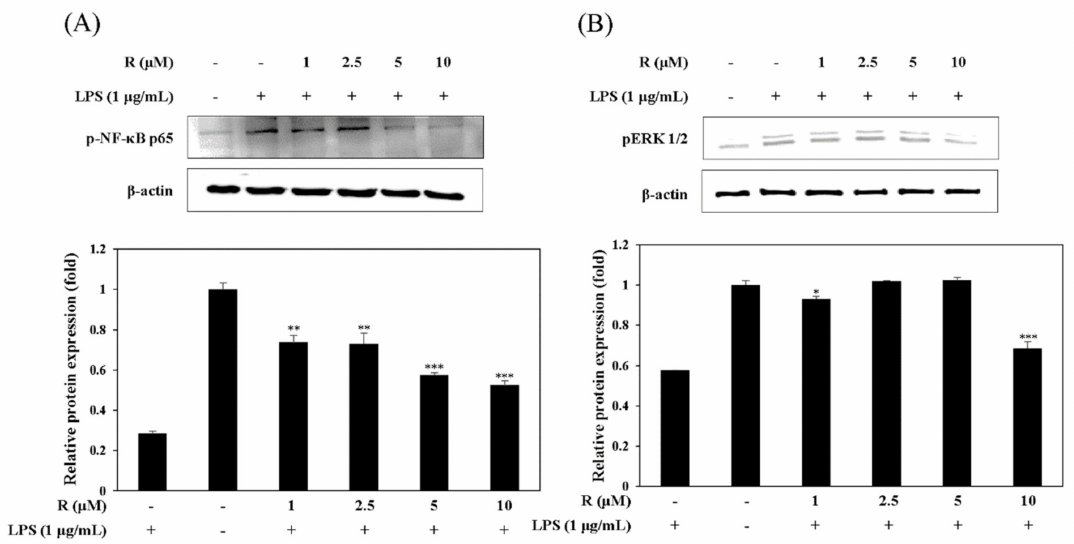
Figure 7. E ff ect of R on NF- κ B activation ( A ) and pERK1 / 2 expression ( B ). RAW 264.7 cells were cultured in the presence of R for 16 h and stimulated with LPS (1 µ g / mL) for 1 h under serum-free conditions. The expression of NF- κ B, p65, and pERK1 / 2 was detected by Western blot analysis. The results presented are representative of three independent experiments. The relative density was calculated as the ratio of the expression level of each protein with that of β -actin. * p < 0.05, ** p < 0.01, *** p < 0.001 vs. LPS-treated